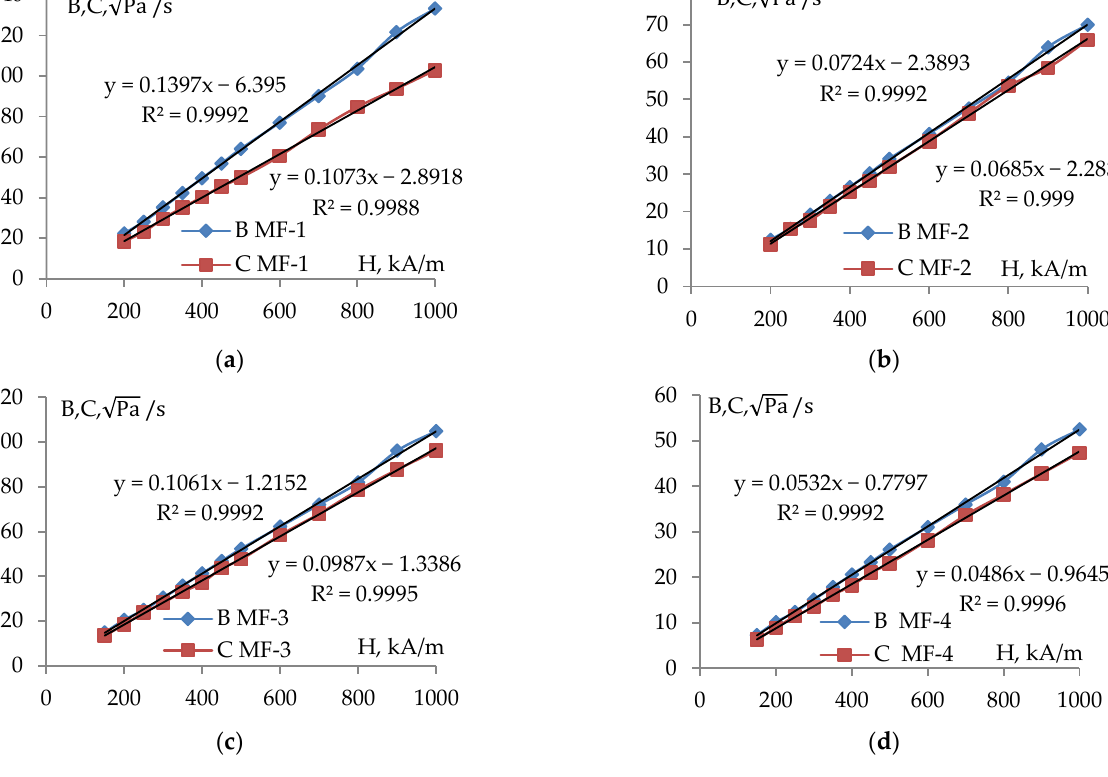
Figure 5. Dependences of parameters B and C: ( a ) MF-1, ( b ) MF-2, ( c ) MF-3, ( d ) MF-4.